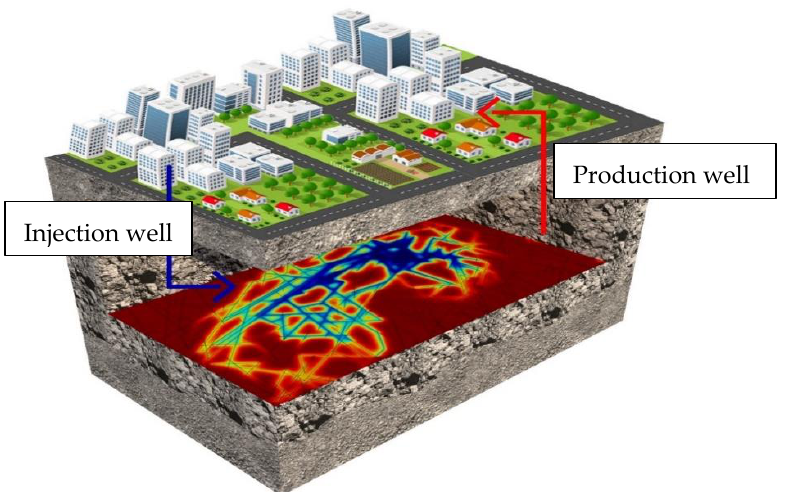
Figure 1. An enhanced geothermal system. The subsurface plan shows an intricate network of fractures. For optimized power generation, appropriate placement of the injection and production wells is necessary.